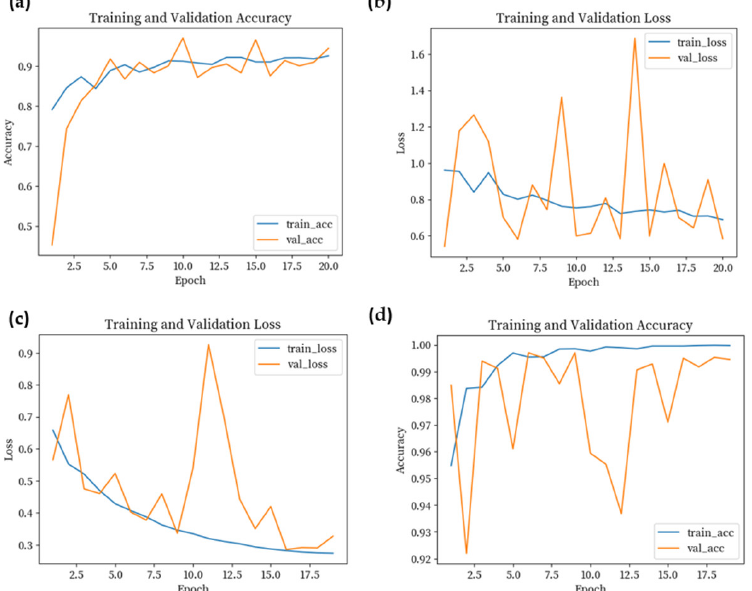
Figure 10. The training and validation accuracy and loss versus the number of training epochs. ( a ) Accuracy of two-class classification for original images; ( b ) loss of two-class classification for original images; ( c ) accuracy of two-class classification for generated images; ( d ) loss of two-class classification for generated images.